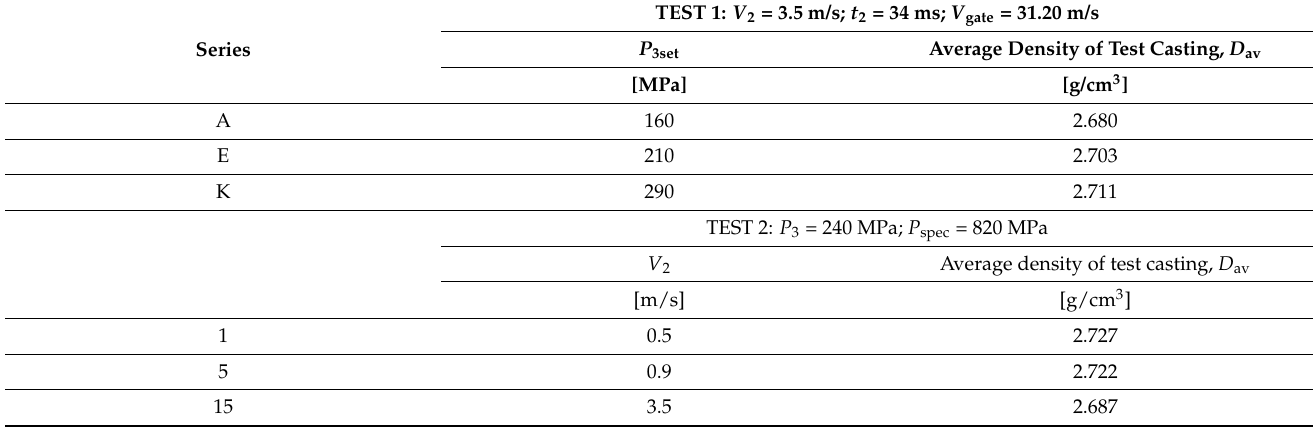
Table 3. Results of the average casting density